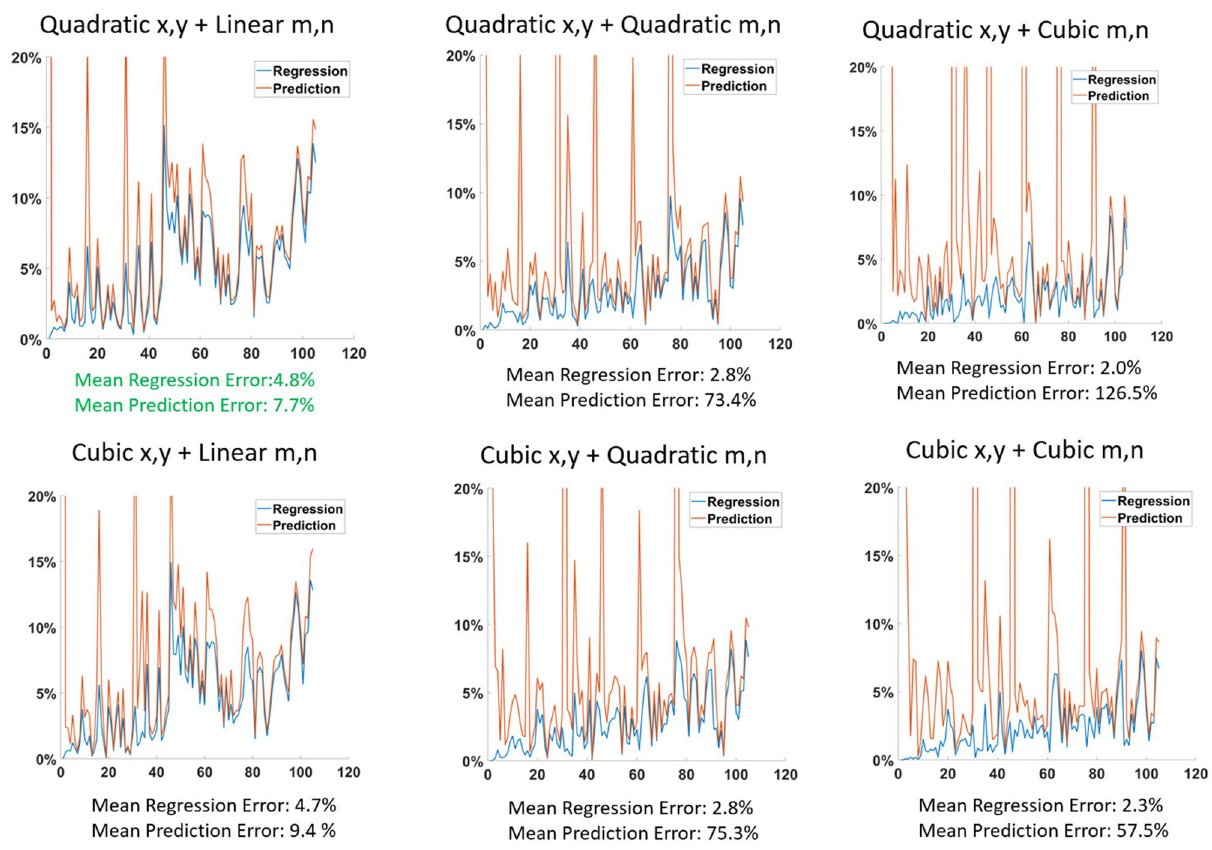
Figure 8. Prediction and regression errors for different models based on measurements from 7 different poses. In each graph the horizontal axis represents the sequentially numbered target fixations and the vertical axis shows the fractional regression and prediction errors as percentages of the full screen width. The mean over the full trial for regression and prediction errors for each model are shown under each graph. The smallest mean regression error is obtained with largest model, but the smallest prediction error is obtained for the model that is quadratic in pupil coordinates and linear in eye corner coordinates.